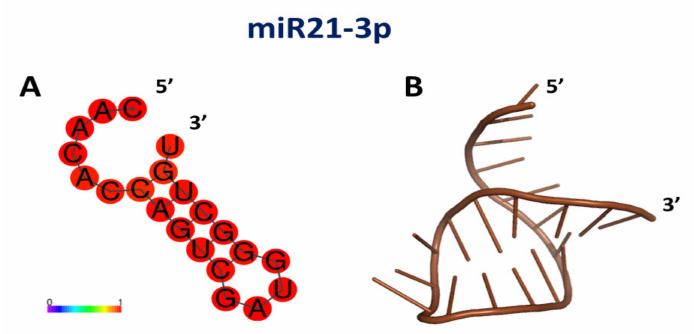
Figure 5. ( A ) Drawing of the best model for the secondary structure of miR21-3p; colors of the spots indicate the corresponding pair-base probability (see the scale at the bottom). ( B ) Graphical representation of the 3D best model for the tertiary structure of miR21-3p, as derived using the secondary structure in A) together with related dot-bracket notation.